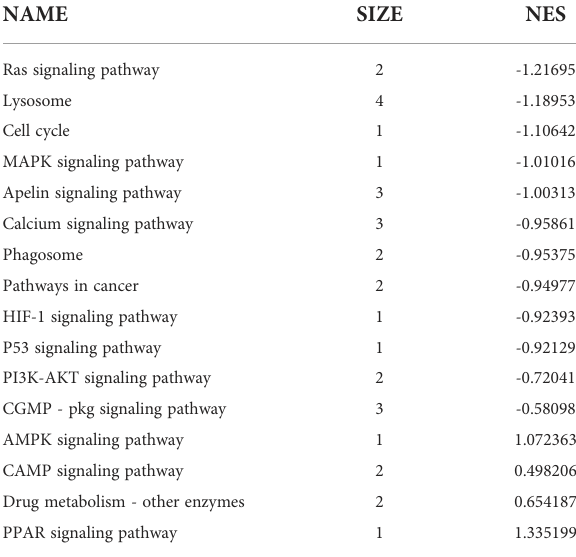
TABLE 1 The results of the enrichment score of each pathway by GSEA.